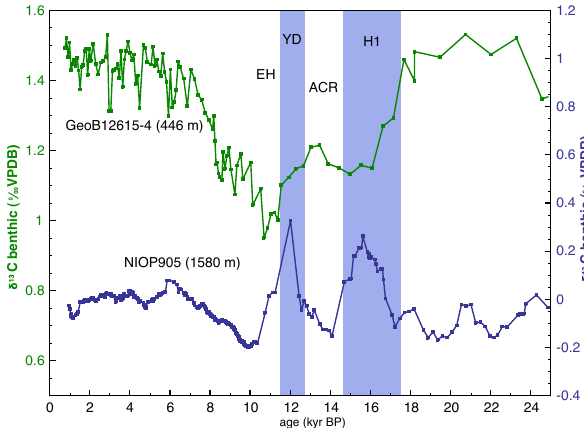
Fig. 6. Comparison of the benthic carbon isotope record of GeoB12615-4 (‰ VPDB; green) and ice core reconstructions of atmospheric δ 13 C ( δ 13 C atm ) for the last 24kyr (yellow, Schmitt et al., 2012).